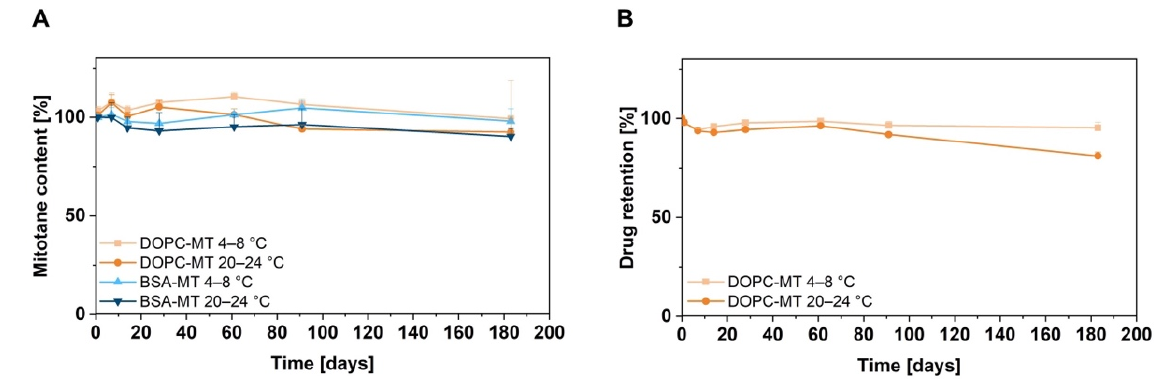
Figure 3. Stability analysis of the mitotane content of albumin-stabilized mitotane (BSA-MT) and liposomal mitotane (DOPC-MT) under different storage conditions. Aliquots of the samples were stored at 4–8 °C or 20–24 °C for 6 months (183 days) and analyzed for their mitotane content. ( A ) Mitotane content given in % of the initial drug content. ( B ) Drug retention of DOPC-MT. A value of 100% indicates no change in drug-to-lipid ratio and thus no drug leakage from liposomes. Data are expressed as mean ± SD, n = 3.